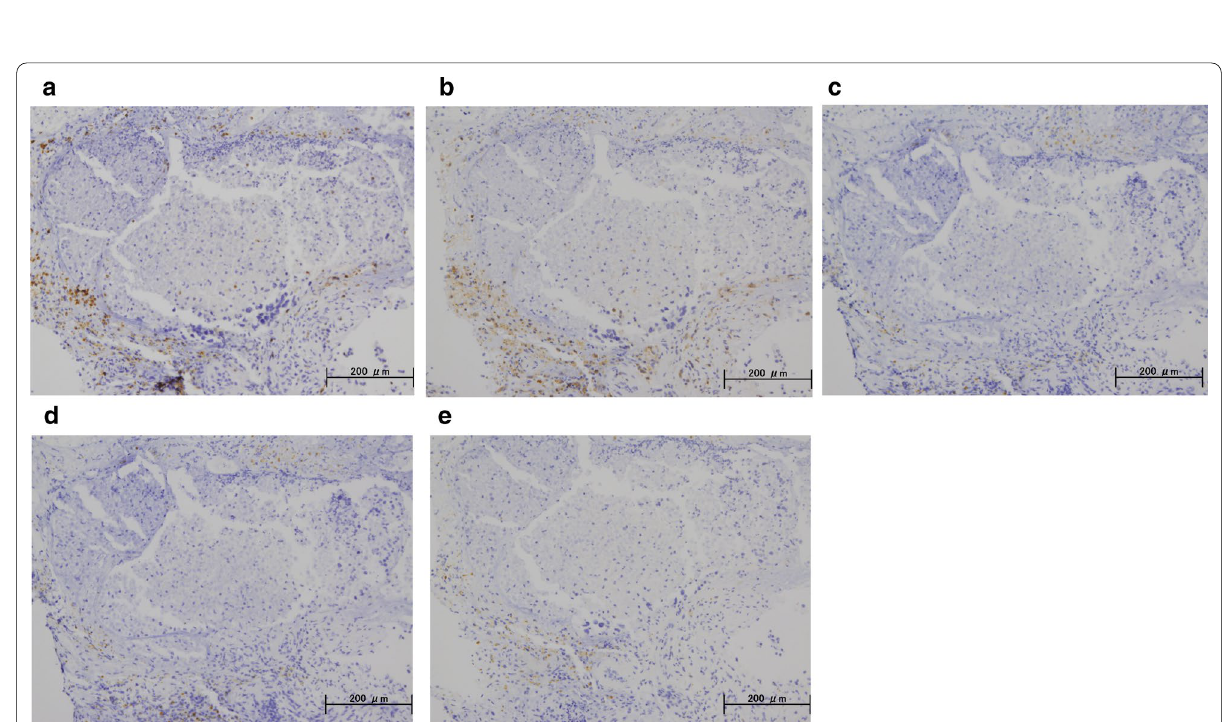
Fig. 3 Immunohistochemical staining for core needle biopsy specimens. Immunohistochemistry study for immunological surface markers ( a CD3; b CD4; c CD8; d CD20; e CD56. All original magnifications are 200). The necrotic area in needle biopsy did not contain immune ×